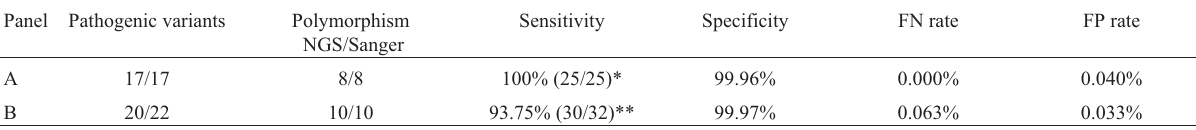
Table 2 - Analytical sensitivity, specificity, FN and FP rates for both TNGS panels.